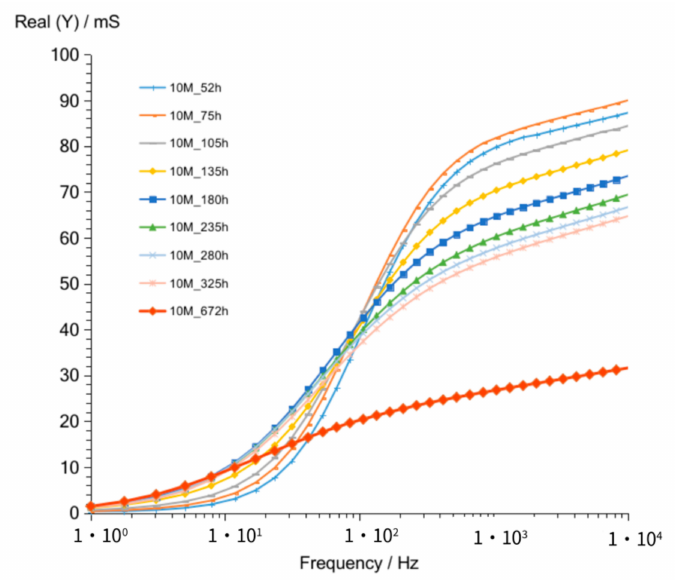
Figure 7. Admittance of G10M geopolymer concrete taken after 52 to 672 h from starting polymerization.